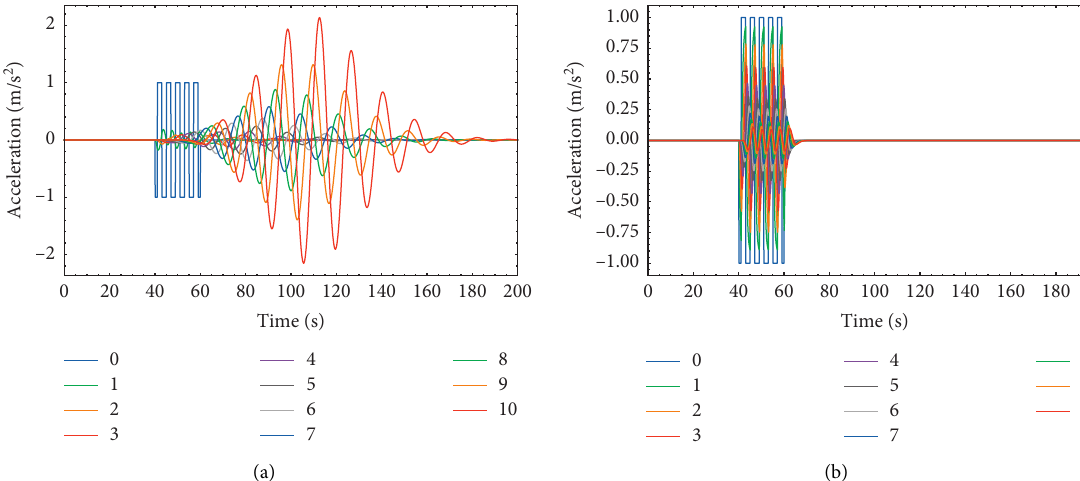
Figure 4: Stability of heterogeneous traffic flow with different desired time gap policies. (a) CTG policy with t t min